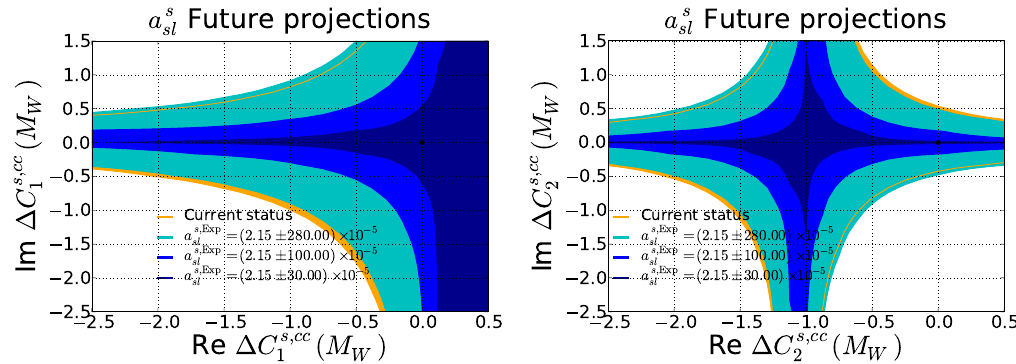
and resulting constraints on sl